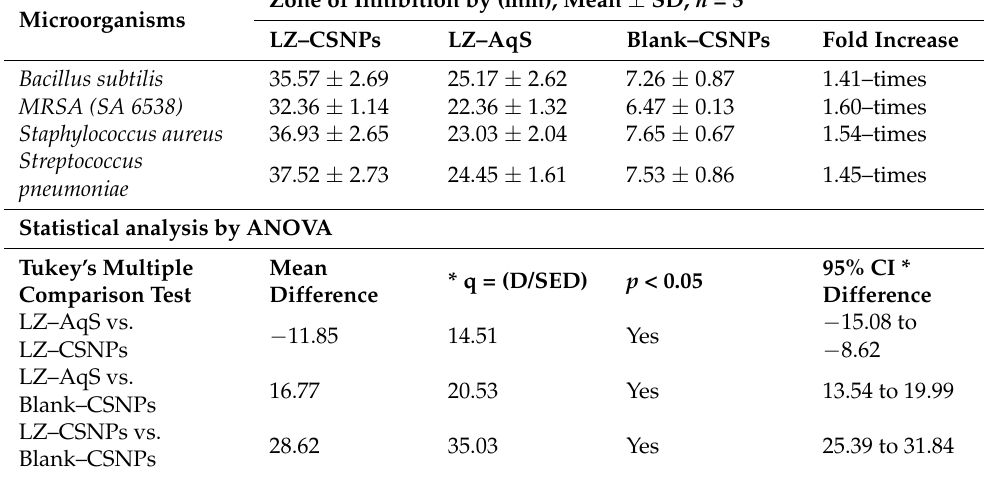
Table 3. The zone of inhibitions achieved through the agar diffusion test by LZ–CSNPs as compared to LZ–AqS. Results were represented as the mean of three measurements with standard deviation (Mean ±